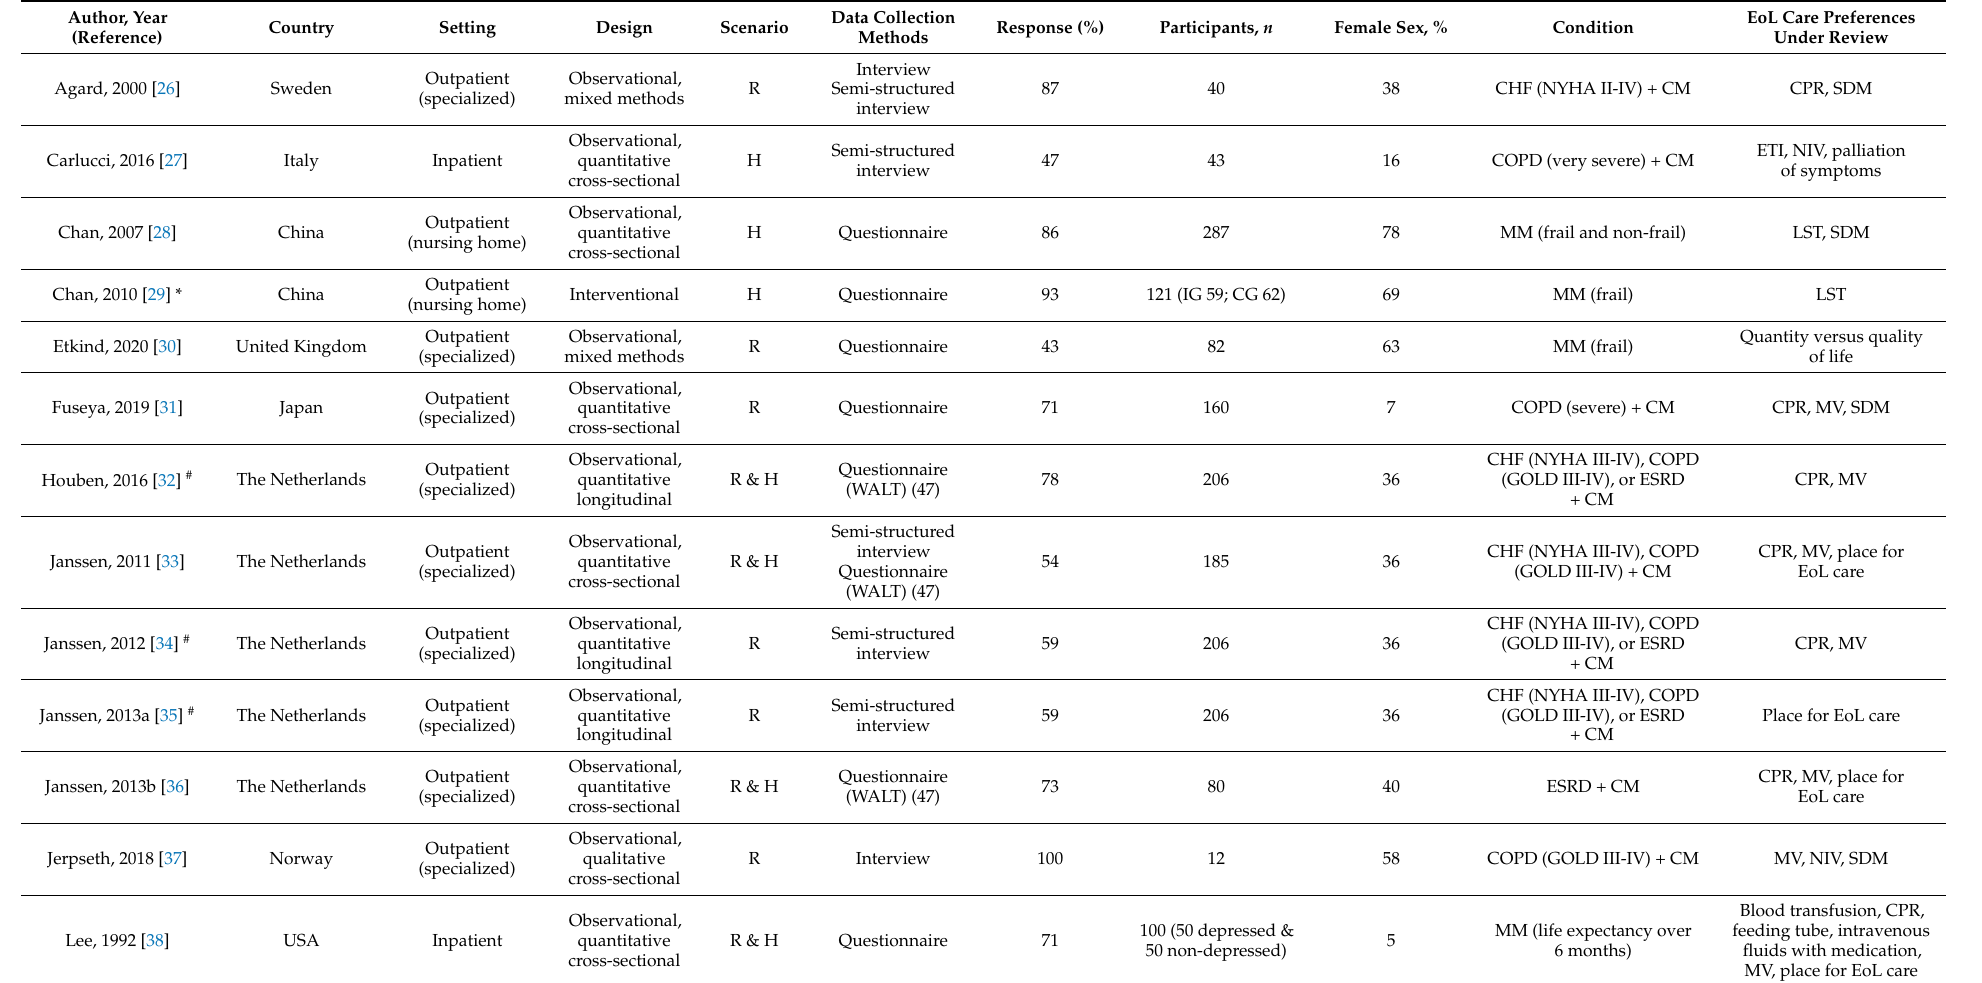
Table 1. Key characteristics of the included